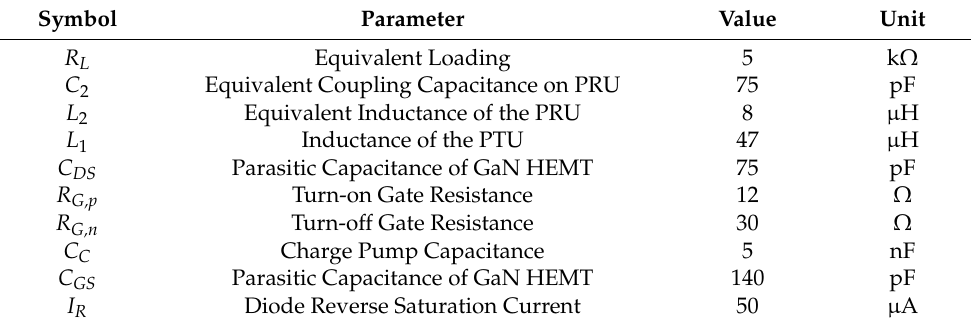
Figure 1. Implementation of the WPT system: ( a ) high-level block diagram and ( b ) class-E amplifier as the power transmission unit. Table 1. Parameters used in the class-E amplifier model and charge pump gate drive.